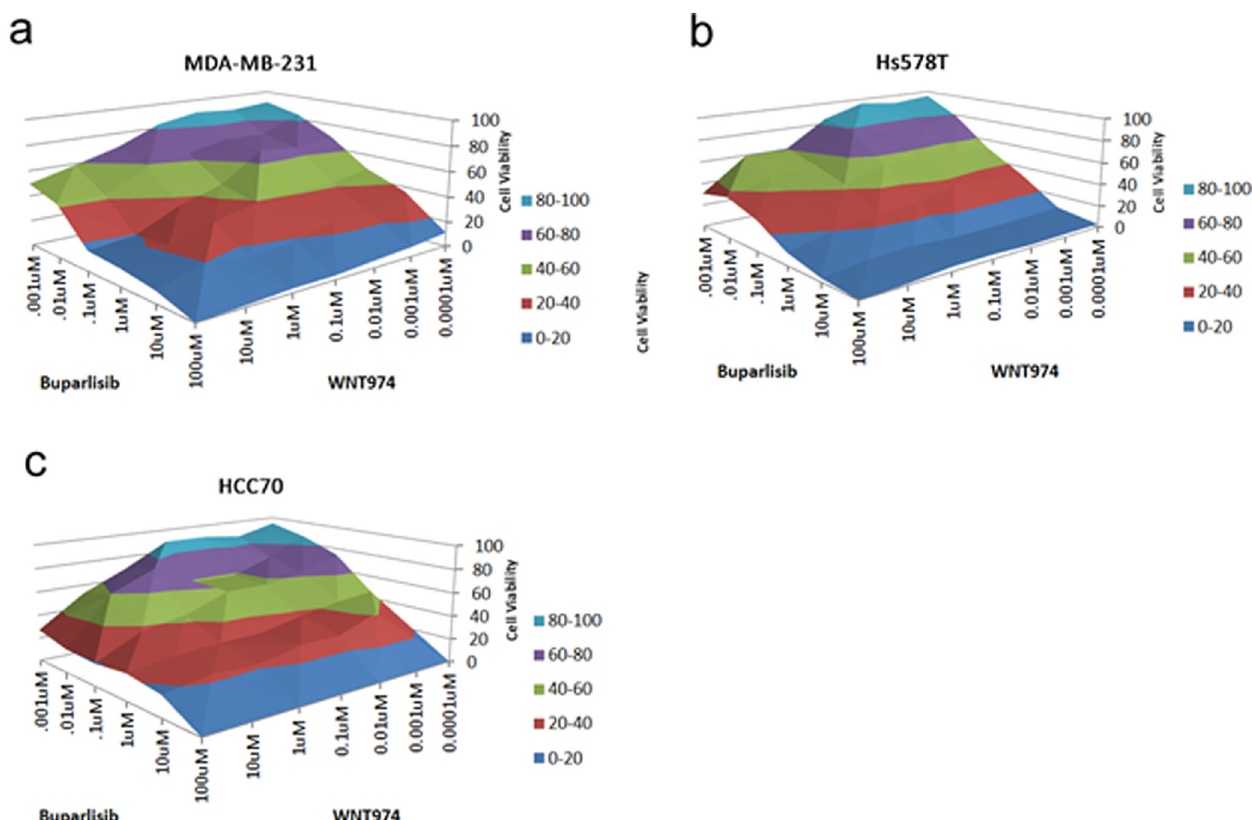
Fig. 3 In vitro ef fi cacy of buparlisib and WNT974 across three TNBC cell lines. Buparlisib and WNT974 were dosed at increasing concentrations ( x and y -axes), and the percentage of cell viability was measured ( z -axis) for cell lines: MDA-MB-231 ( a ), Hs578T ( b ) and HCC70 ( c ). Data is displayed as a cascade plot. Using the Chou – Talalay method, we observed for MDA-MB-231 and Hs578T, a ~50% reduction in cell viability at 100 nM concentration of each drug that was highly synergistic (combination index = 0.33 and 0.36, respectively). For HCC70, we observed an additive effect that was more resistant to the combination with an IC50 of 1 μ